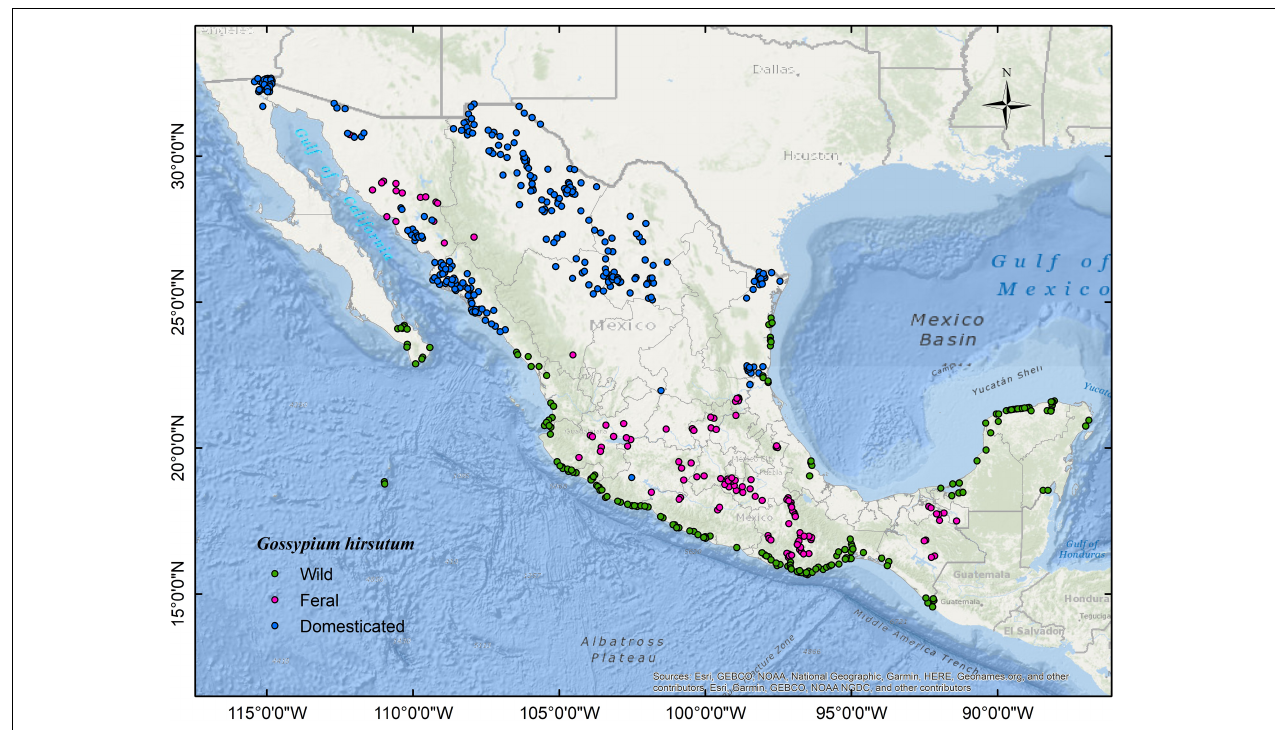
FIGURE 1 | Map of the study area showing occurrence data: wild cotton ( n = 175; green), feral cotton ( n = 120; magenta), and highly domesticated cultivars, hereafter referred to as “domesticated” ( n = 278; blue).